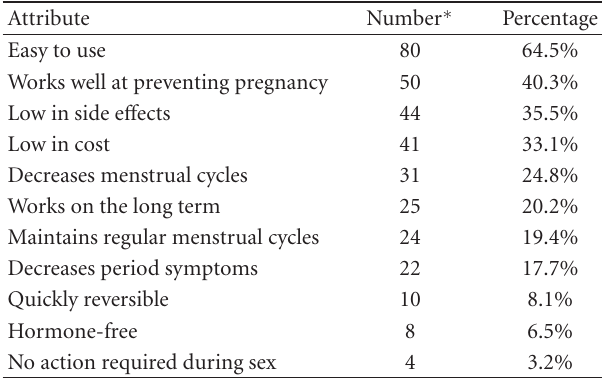
Table 4: Most important attributes of contraceptive method (women were asked to pick their top 3